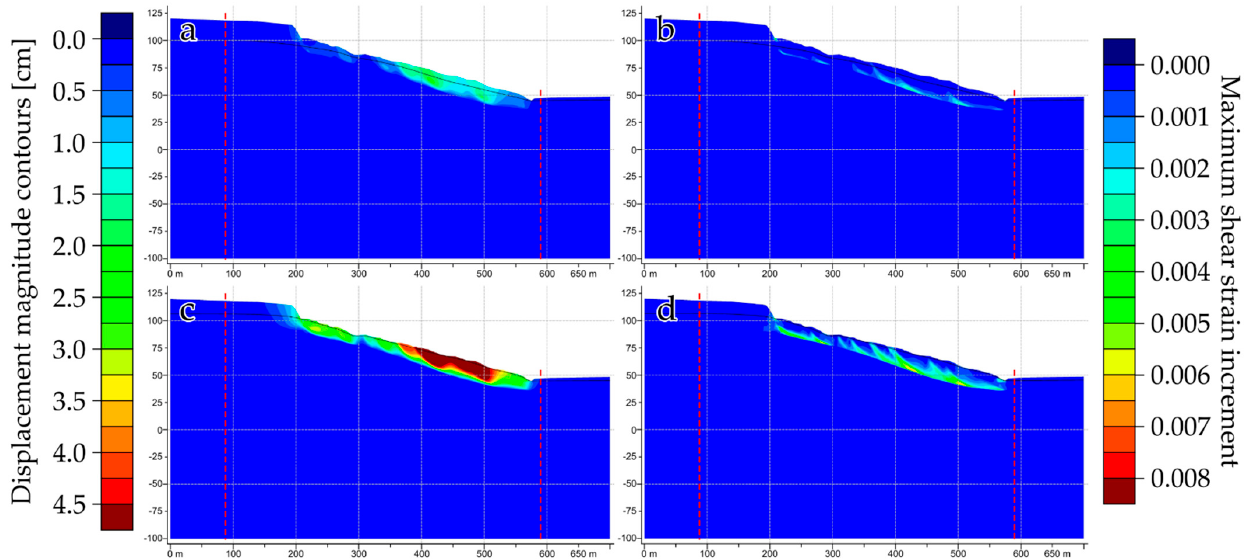
Figure 13. Influence of the water level in the dynamics and mechanism of the landslide–Contours of displacement magnitude ( left ) and maximum shear strain increment ( right ) for the low level of the water table ( a , b , respectively) and the high level of the water table ( c , d , respectively). (high-resolution image available at https://doi.org/10.6084/m9.figshare.14920137.v2).